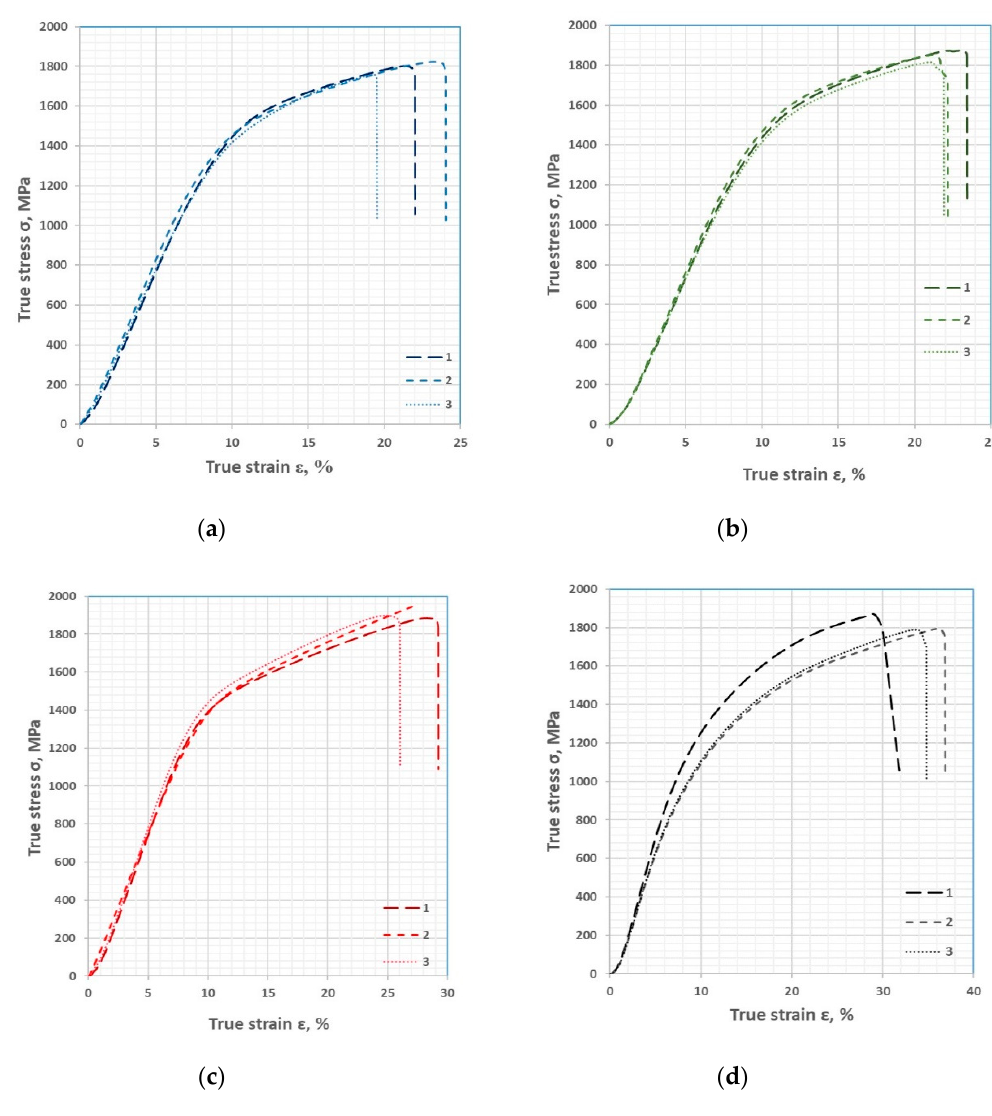
Figure 10. Compression diagrams of samples with different track layouts: ( а ) “Parallel”; ( b ) 6— “perpendicular”; ( c ) “vertical”; ( d ) “mixed”; 1,2,3—sample test